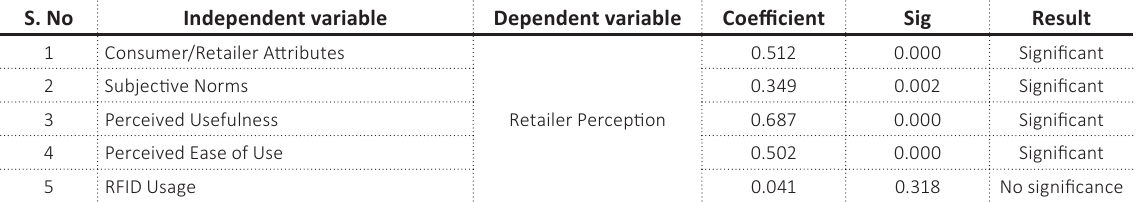
Table 5. Hypotheses testing (dependent variable – retailer perception) S. No